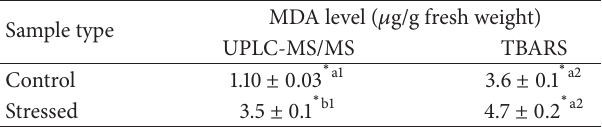
Values are means ± standard deviation. Table 3: Comparison between MDA levels determined by the pro- posed UPLC-MS/MS method and the traditional TBARS